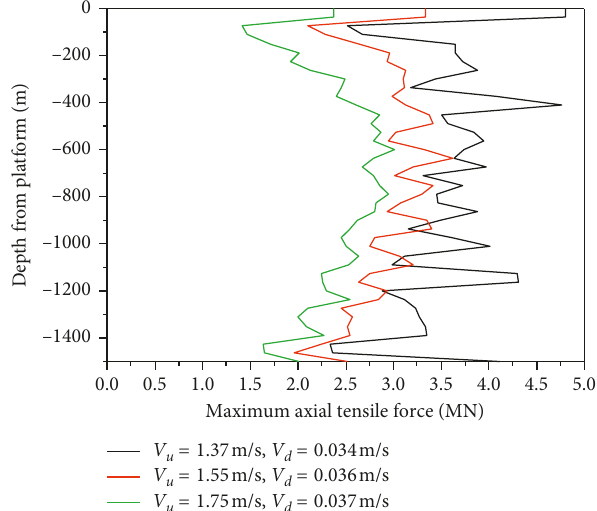
Figure 14: Effect of shear velocity on maximum dynamic moment.